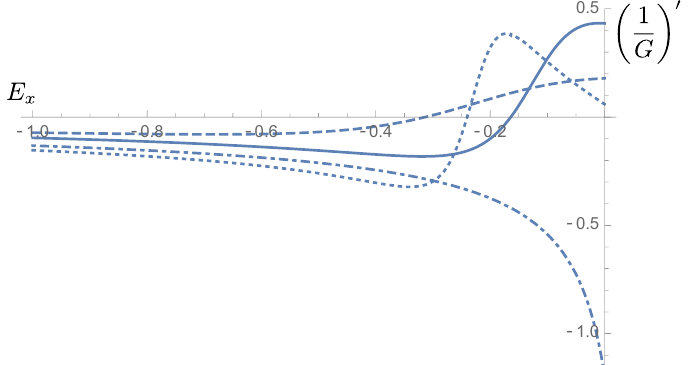
Figure 3. Behavior of the derivative of 1/ G ( E x ) for the potential barriers considered in Figure 2. Three of them fulfill the condition that ensures monotonicity for T DT , whereas one does